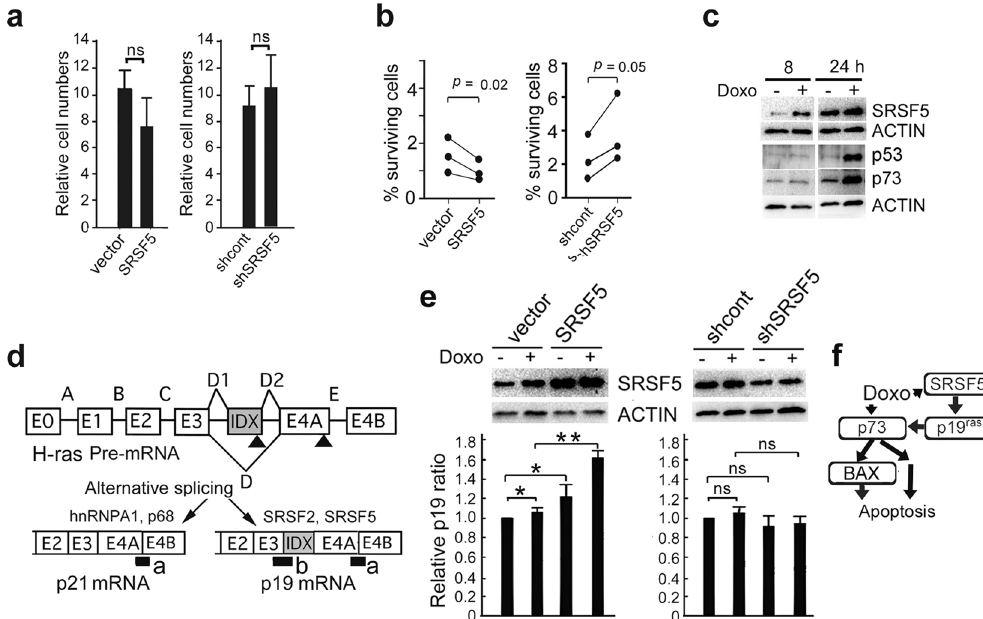
Figure 3. Effects of SRSF5 on cell proliferation. ( a ) Stable transfectants of U-2 OS cells overexpressing SRSF5, vector alone, shRNA control and shRNA against SRSF5 (shSRSF5) were cultured at 37 °C for 4 days. Cell numbers were determined and expressed as relative to those at day 0 (mean ± SEM; n = 3). ns, P > 0.05. ( b ) Transfectants were cultured at 37 °C in the presence of 100 nM doxorubicin (Doxo) for 4 days. Numbers of surviving cells were determined and compared with those of untreated cells (data indicate mean ± SEM; n = 3). ( c ) U-2 OS cells were cultured at 37 °C in the presence ( + ) or absence ( − ) of 100 nM Doxo for 8 or 24 h, and analyzed by western blot (representative of 4 independent experiments). ( d ) Scheme of the Taqman assays used to determine endogenous p19 and total (p19 and p21) H-RAS mRNA expression. cDNA regions amplified by E4A-E4B and E3-IDX primer pairs are indicated by a and b, respectively. E0 to E4B, exons of human H-RAS gene. Arrow heads, stop codons. ( e ) Transfectants were cultured as in ( c ) for 10 h, and analyzed by western blot and the Taqman assays (upper panels, representative results). Relative p19 ratio, the p19/total H-RAS mRNA ratio obtained for each sample after normalization to 18S rRNA, and expressed as relative to that of control cells cultured without Doxo (mean ± SEM; n = 3). * , P < 0.05. ** , P < 0.01. ns, P > 0.05. ( f ) A model how